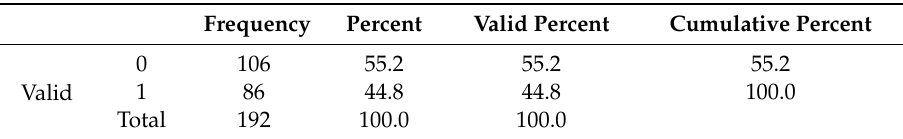
Table 18. Frequency table: car sharing is ecofriendly.